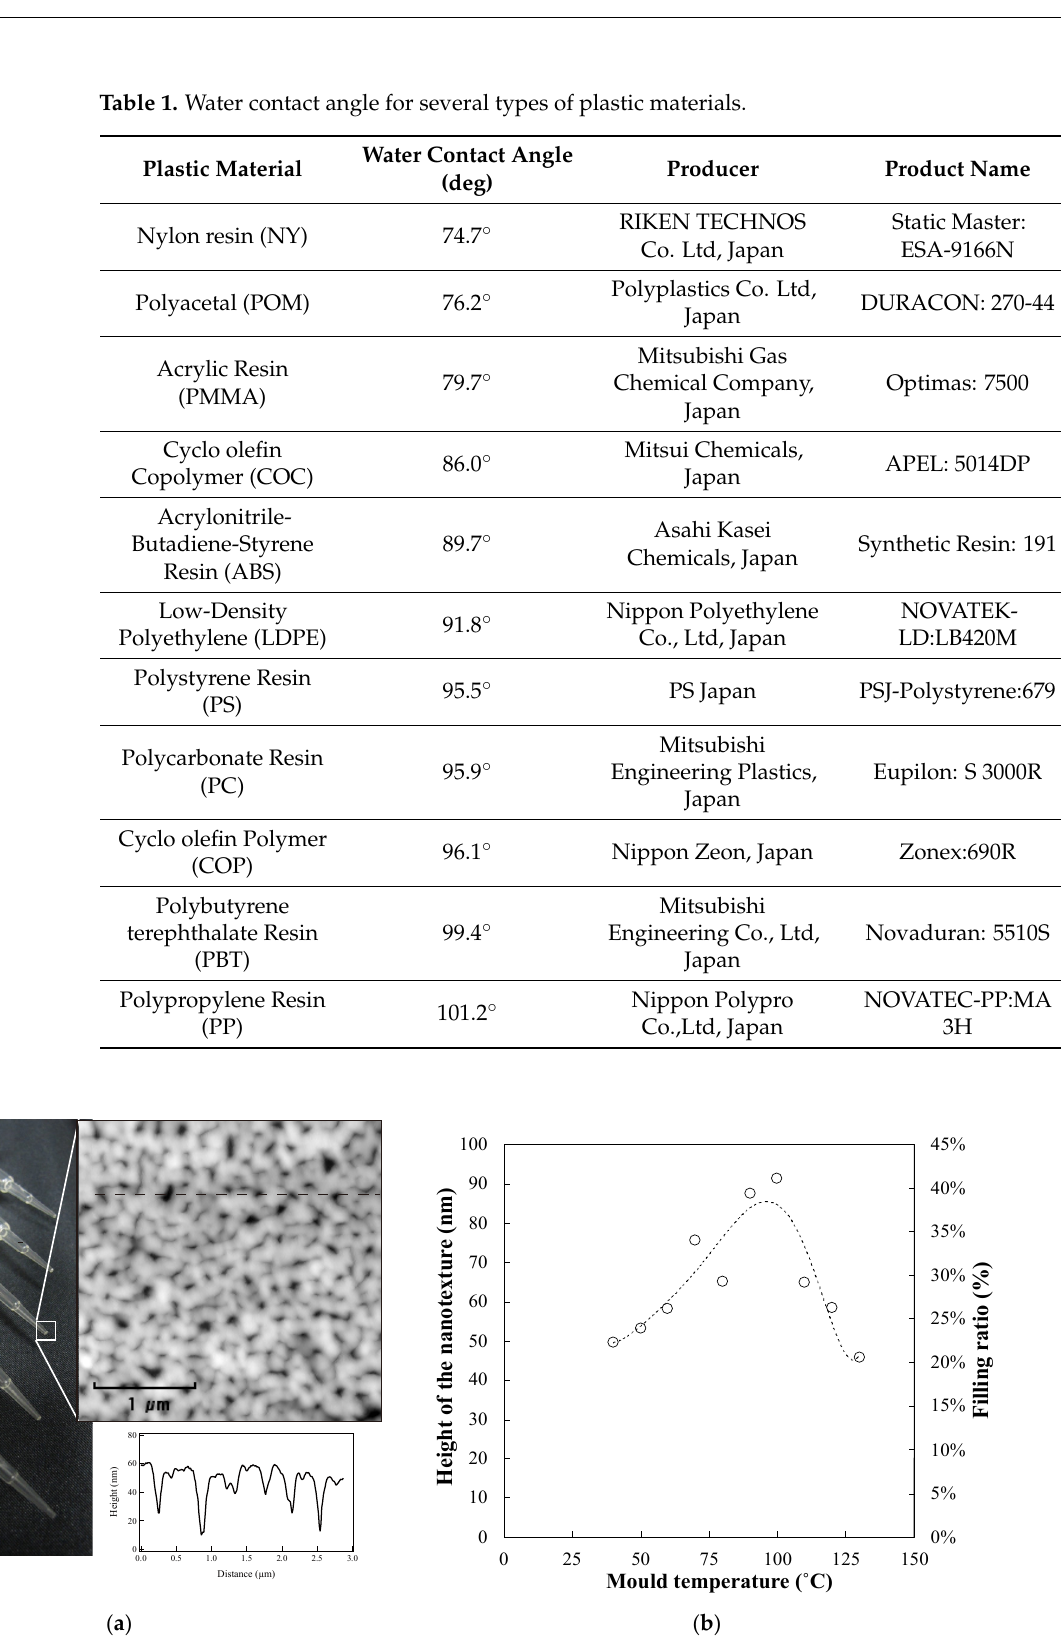
Figure 5. ( a ) AFM image of the replicated plastic tip surface and ( b ) replication height of the nanotexture as a function of the mould temperature.